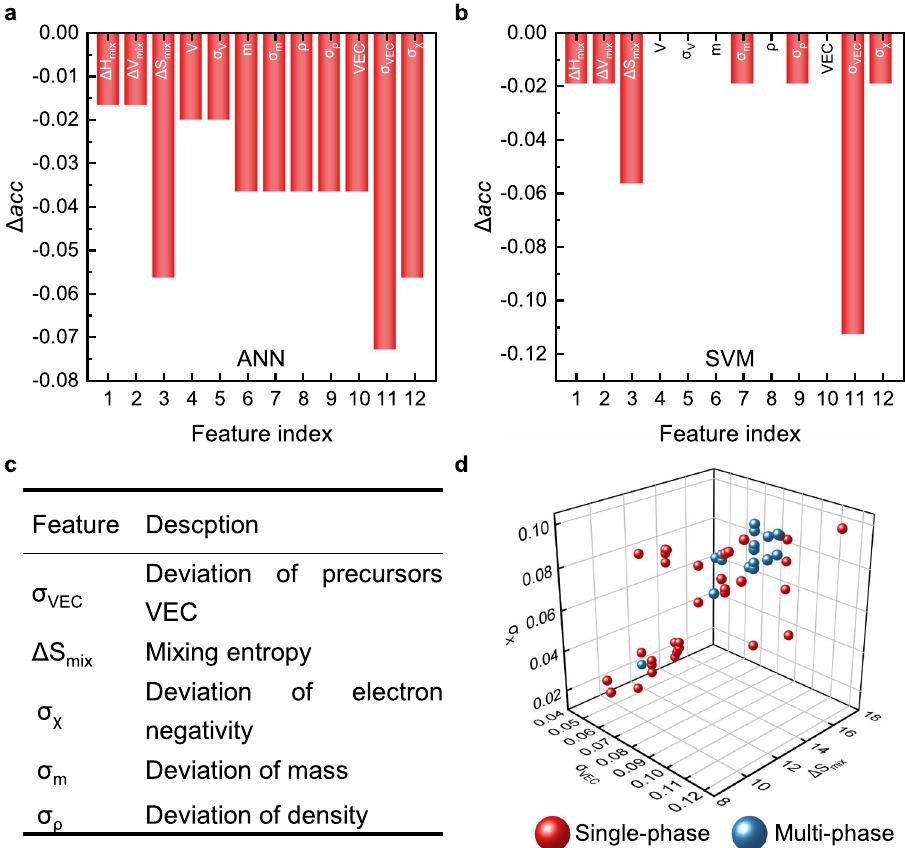
Fig. 5 Relative importance of different features. Feature importance of a ANN and b SVM models. c Top fi ve most important features. d 3D plot of top three most important features, including σ VEC , Δ S mix , and σ χ , against the phase classi fi cation.